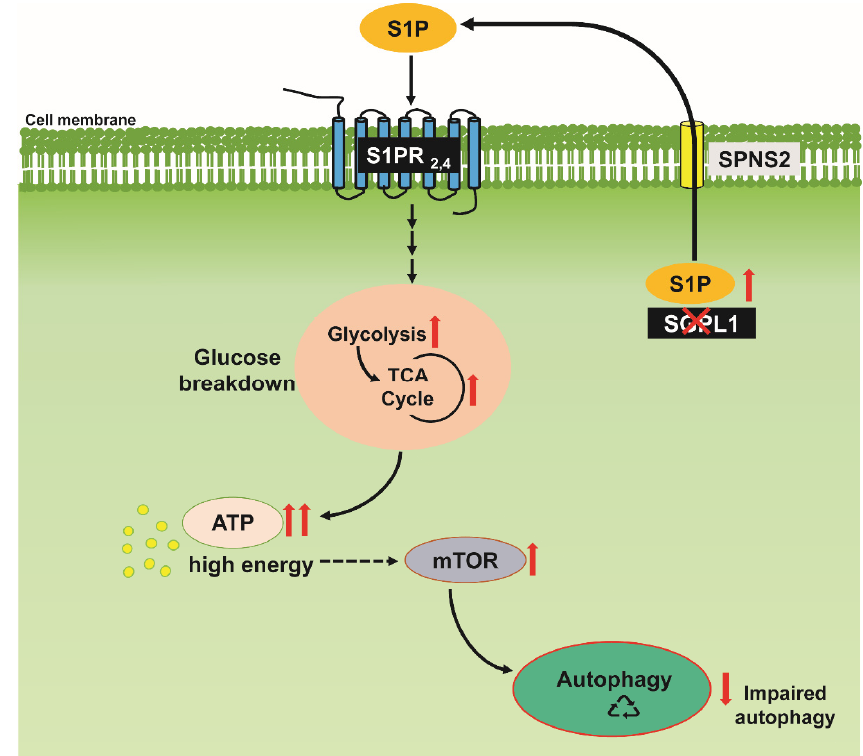
Figure 5. Scheme summarizing the effects of SGPL1 ablation on glucose degradation and autophagy in astrocytes. In the absence of SGPL1, accumulated S1P is released by the cells via SPNS2 and promotes the increased expression and activity of proteins involved in glucose breakdown, acting in an auto- or paracrine manner through S1PR 2,4 . This leads to increased levels of ATP, the activation of mTOR, and reduced autophagy.